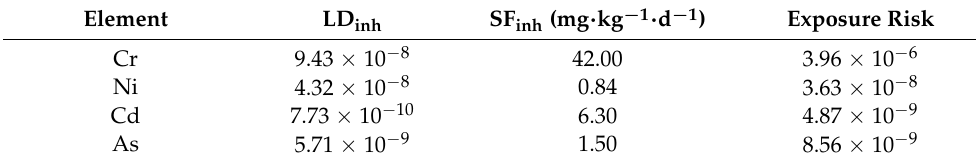
Table 7. Carcinogenic risk values of trace metal in inhalation exposure pathway.